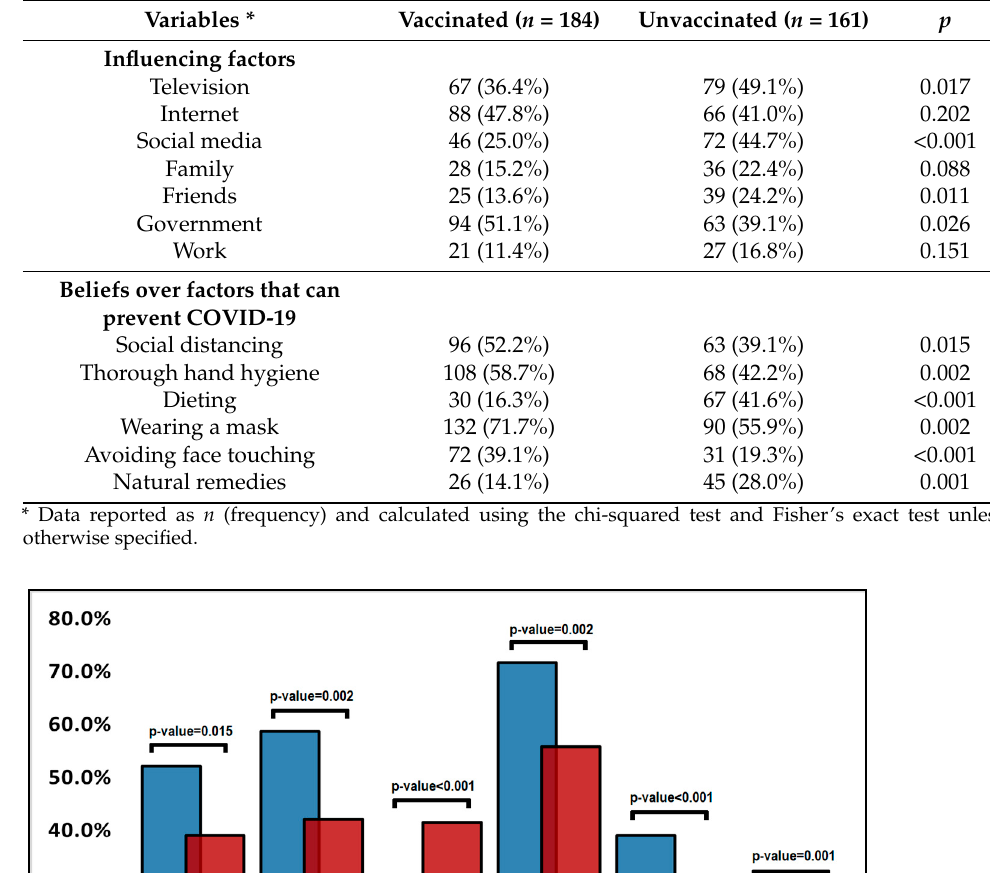
Table 4. Comparison of unstandardized questionnaires between vaccinated and unvaccinated pregnant women.